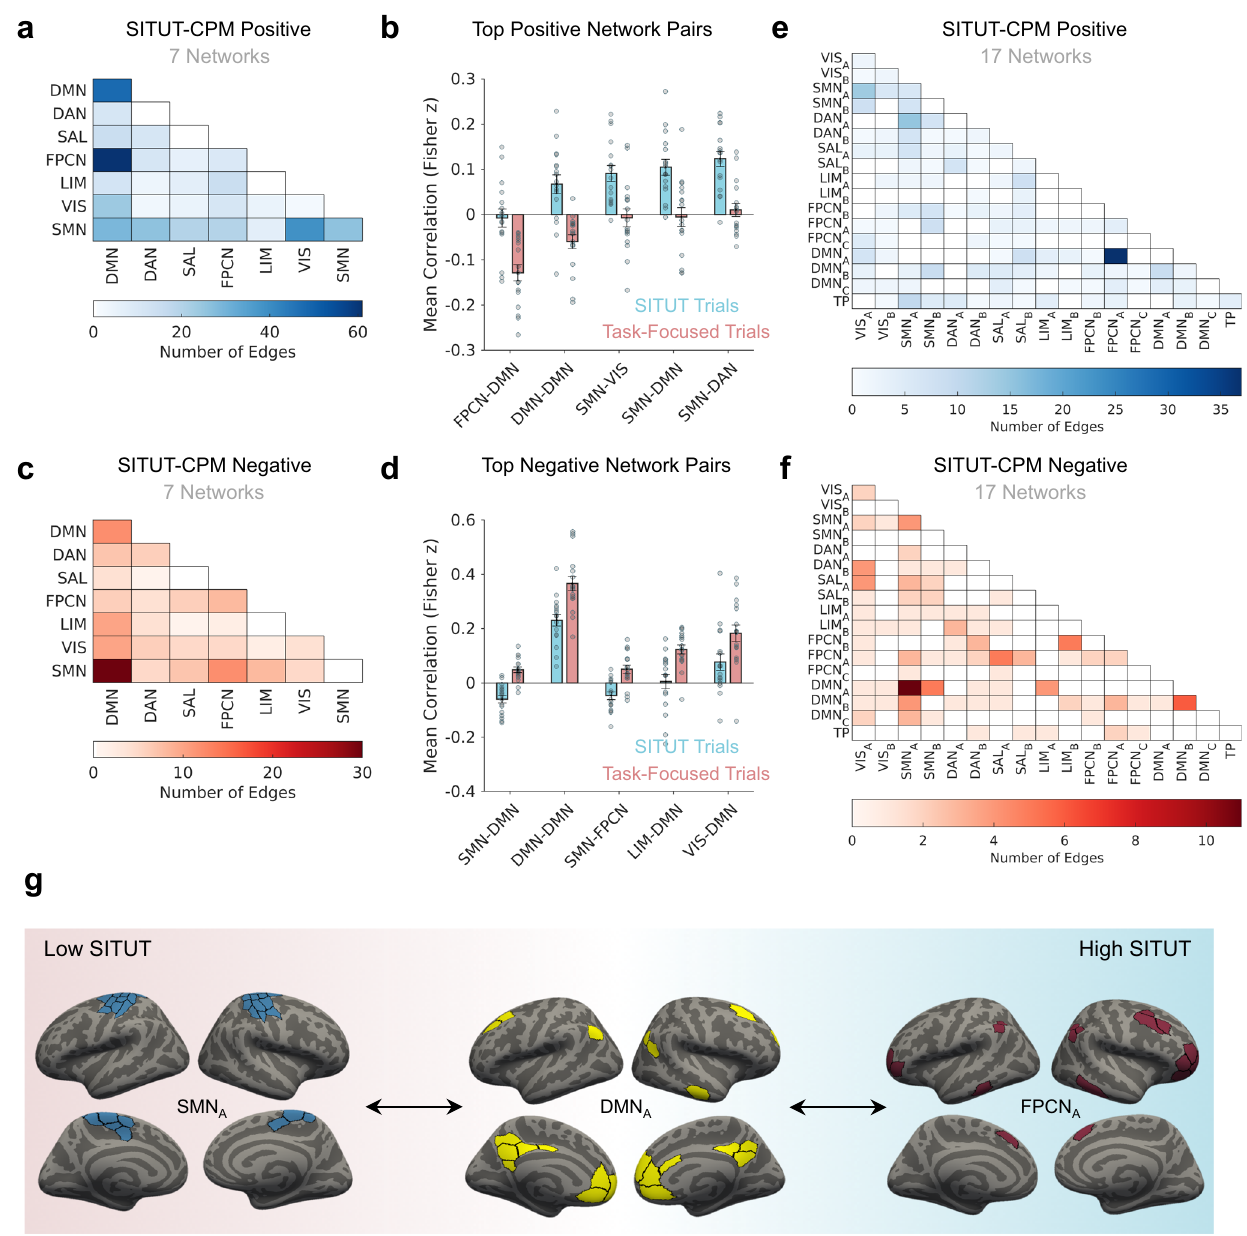
Fig. 2 Functional neuroanatomical basis of the SITUT-CPM network. a The number of edges, among those within the SITUT-CPM positive mask, assigned to each within- or between-network pair based on the Schaefer300 and Yeo-Krienen 7-network atlases. b The mean correlation between CPM network-pair regions as a function of SITUT rating, shown for the top fi ve positive network-pair features. “ SITUT ” and “ Task-Focused ” trial values were derived from a median split of trials, based on SITUT ratings, within each participant ( n = 17 participants). Error bars indicate standard error of the mean. c Same as a , except for the SITUT-CPM negative mask. d Same as b , except for edges negatively correlated with SITUT ( n = 17 participants). e Same as a , except for the Yeo-Krienen 17-network atlas. f Same as b , except for the Yeo-Krienen 17-network atlas. g Summary schematic of major inter-network pairs contributing to the CPM-based SITUT network. DAN dorsal attention network, DMN default mode network, FCPN frontoparietal control network; LIM limbic network, SAL salience network, SMN sensorimotor network, TP temporal-parietal network, VIS visual network, SITUT stimulus-independent, task- unrelated thought, CPM connectome-based predictive model. Source data are provided as a Source data fi le.